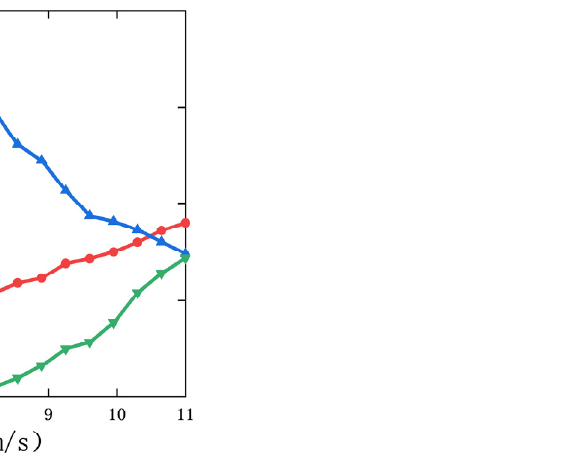
Figure 13. Output power change curve of the PEH, the EEH, and the CGPEH with wind speeds.